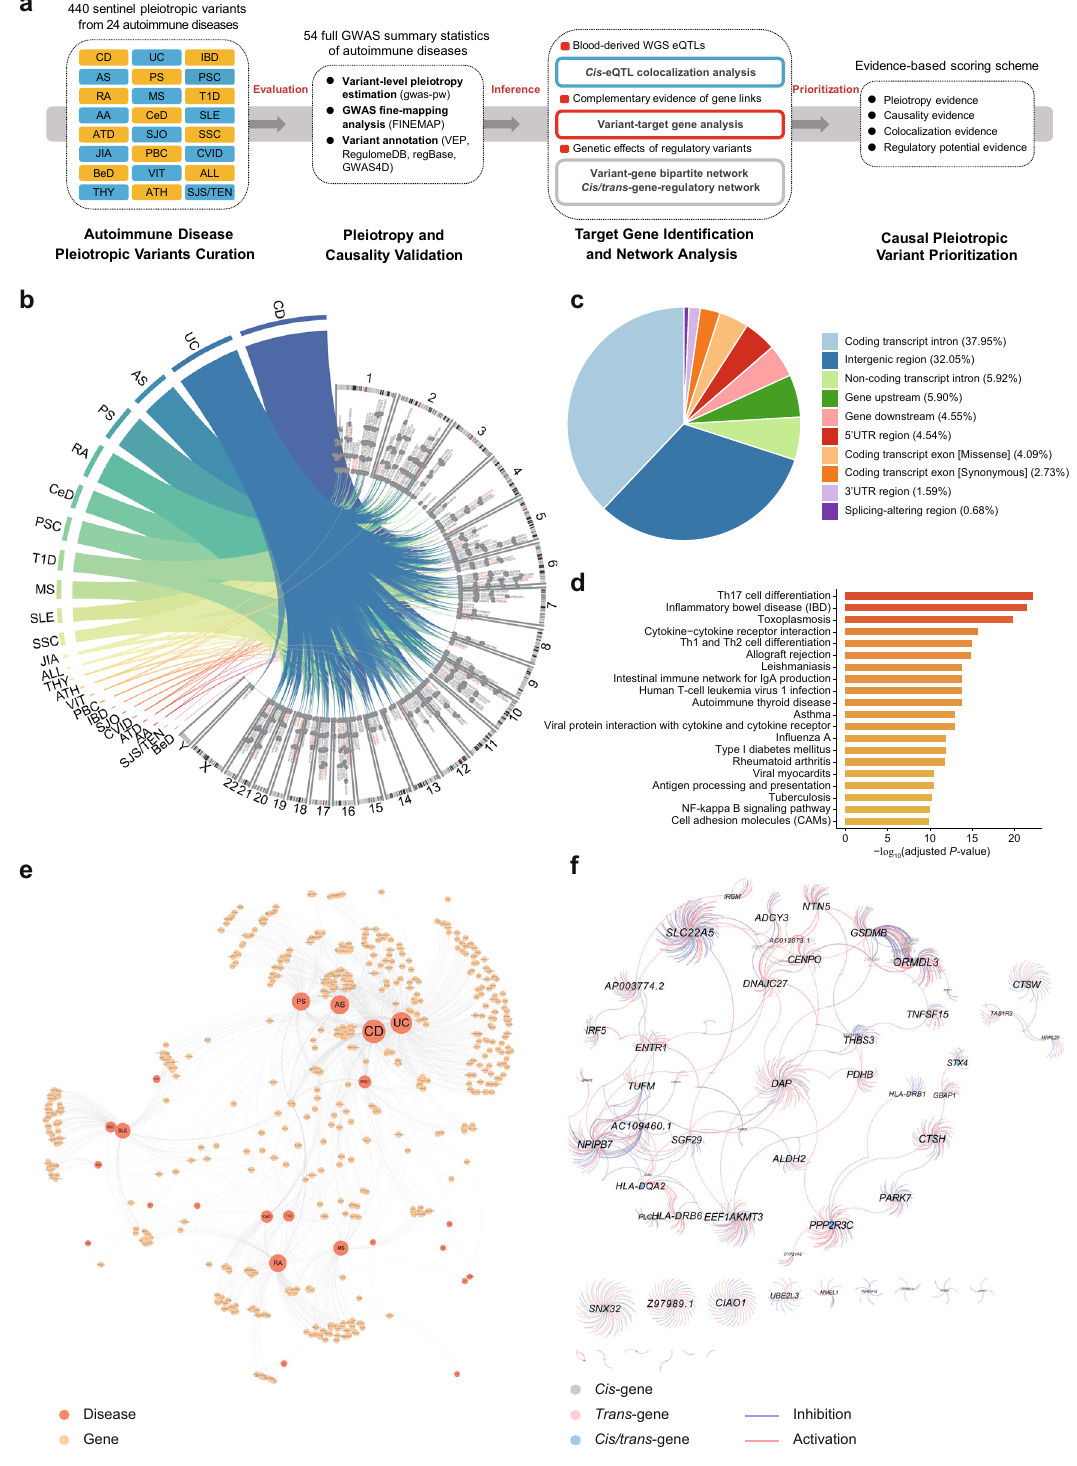
Variant-target gene